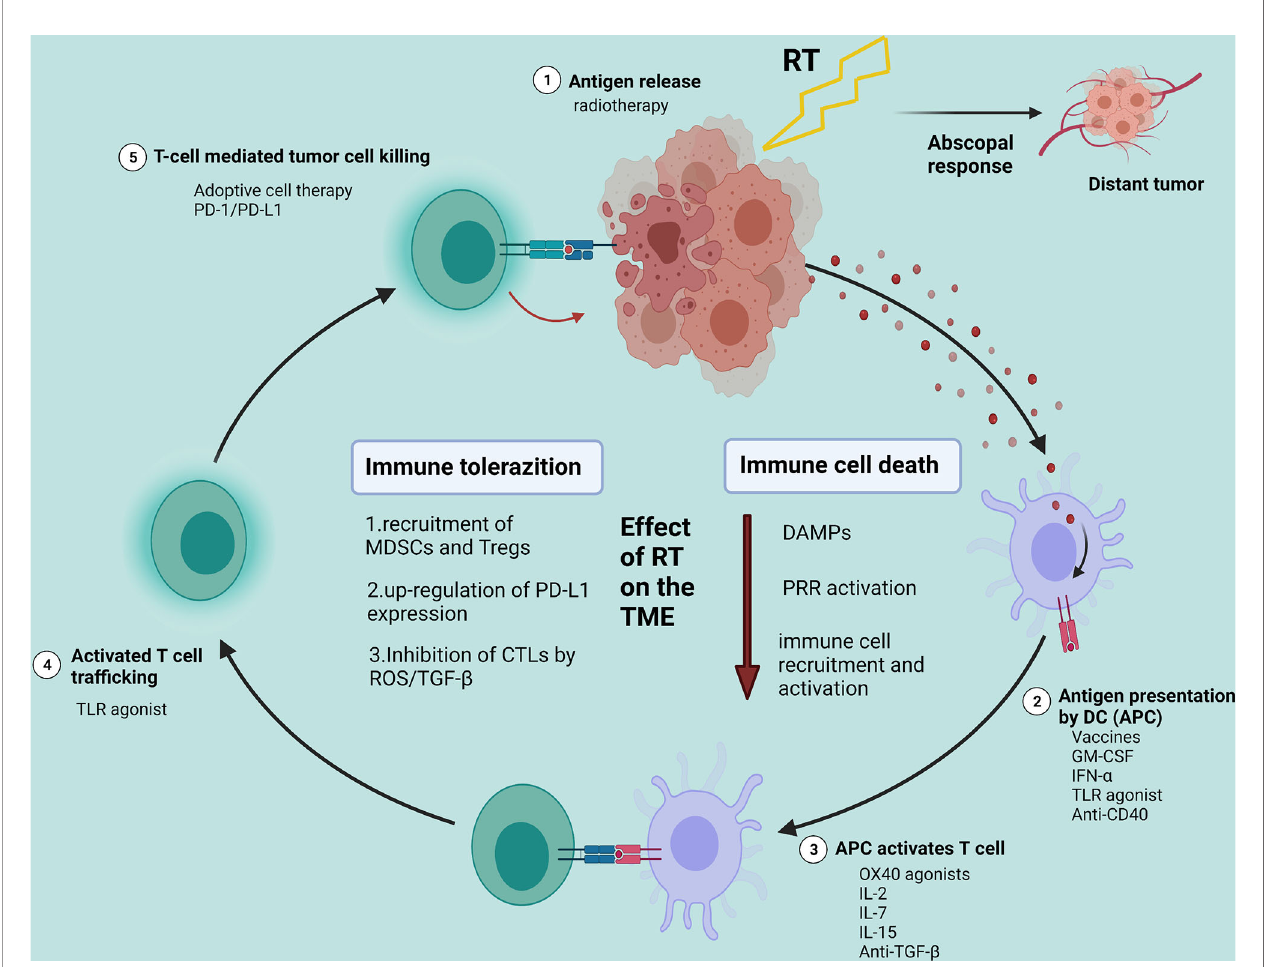
FIGURE 2 | Effects of radiotherapy on the tumor microenvironment and potential strategies for the combination of radiotherapy with different immunotherapies. Created with BioRender.com. RT, radiotherapy; DAMPs, damage-associated molecular patterns; PRR, pattern recognition receptor; TME, tumor microenvironment; MDSCs, myeloid-derived suppressor cells; Tregs, T-regulatory